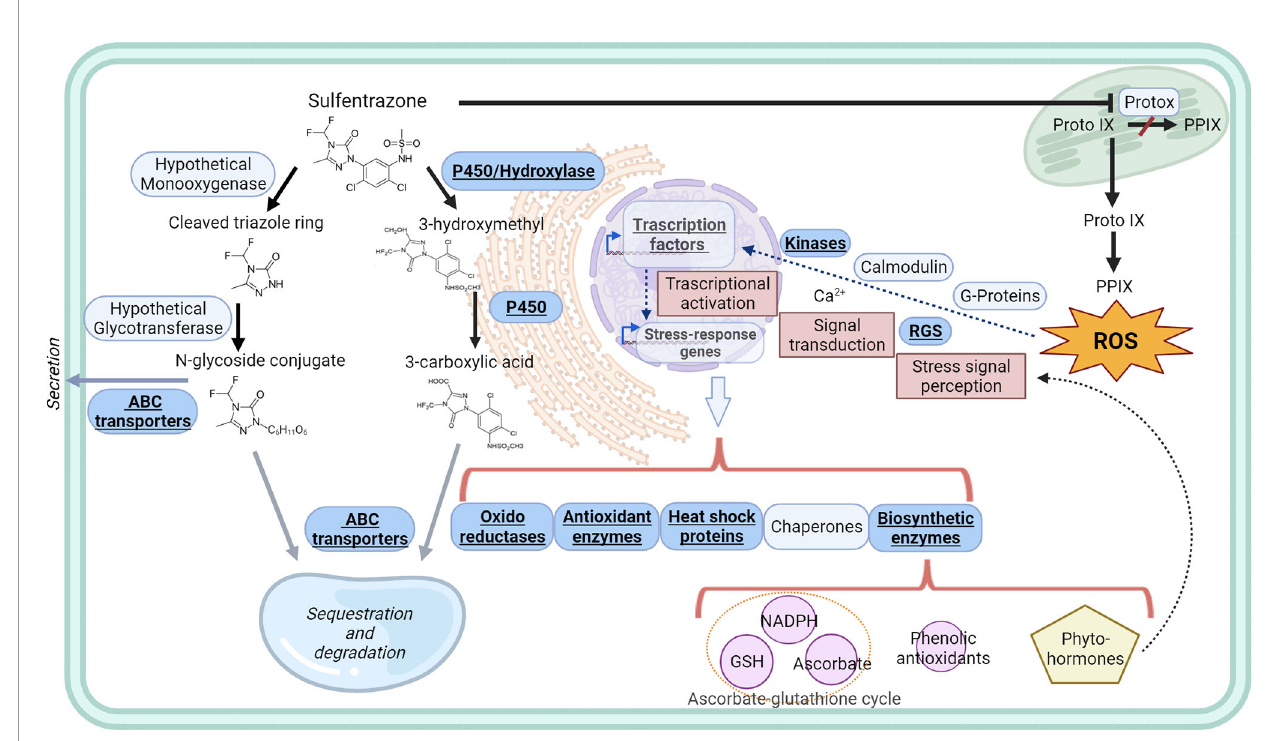
FIGURE 4 | Tolerance to sulfentrazone is mediated by NTSR. Left side of the fi gure: Possible mechanisms and gene products involved in the transformation, transport, and sequestration of sulfentrazone and its metabolites. Solid black arrows show likely metabolic pathways of experimentally observed metabolites in plants. Grey solid arrows show excretion and sequestration of xenobiotics not yet experimentally con fi rmed for sulfentrazone. General mechanisms of plant response to oxidative stress is shown in the right side of the fi gure. Possible roles of the products of the genes identi fi ed in the GWAS analysis are shown within blue boxes in bold font. Sulfentrazone metabolic degradation information from Aizawa and Brown, 1999, and Dylan et al, 1997. General herbicide detoxi fi cation and sequestration information from Gaines et al., 2020; ABC transporter roles from Kang et al., 2011, Conte and Lloyd, 2011; Kyle and Vogt, 2017; and Li and Fengler, 2017. Xenobiotic detoxi fi cation models from Edwards et al., 2011 and Cave ́ -Radet et al., 2020. ROS response models and information from Urano et al., 2013; Demidchik, 2015; and Dumanovic ́ et al., 2021. ABC transporters, ATP-binding cassette transporters; GSH, Glutathione; NADPH, Nicotinamide adenine dinucleotide phosphate; P450, Cytochrome P450 enzyme; PPIX, Protoporphyrin IX; Proto IX, Protoporphyrinogen. IX, RGS, Regulator of G-protein; ROS, Reactive oxygen